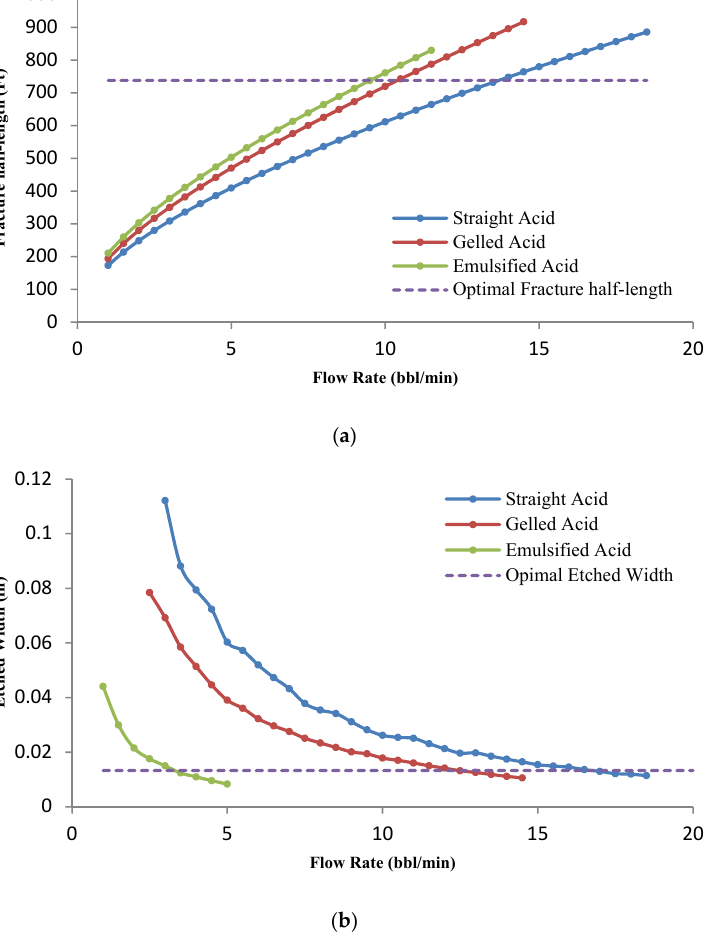
Figure 14. Variations of fracture half-length ( a ) and average etched width ( b ) with flow rate for three acid system types.